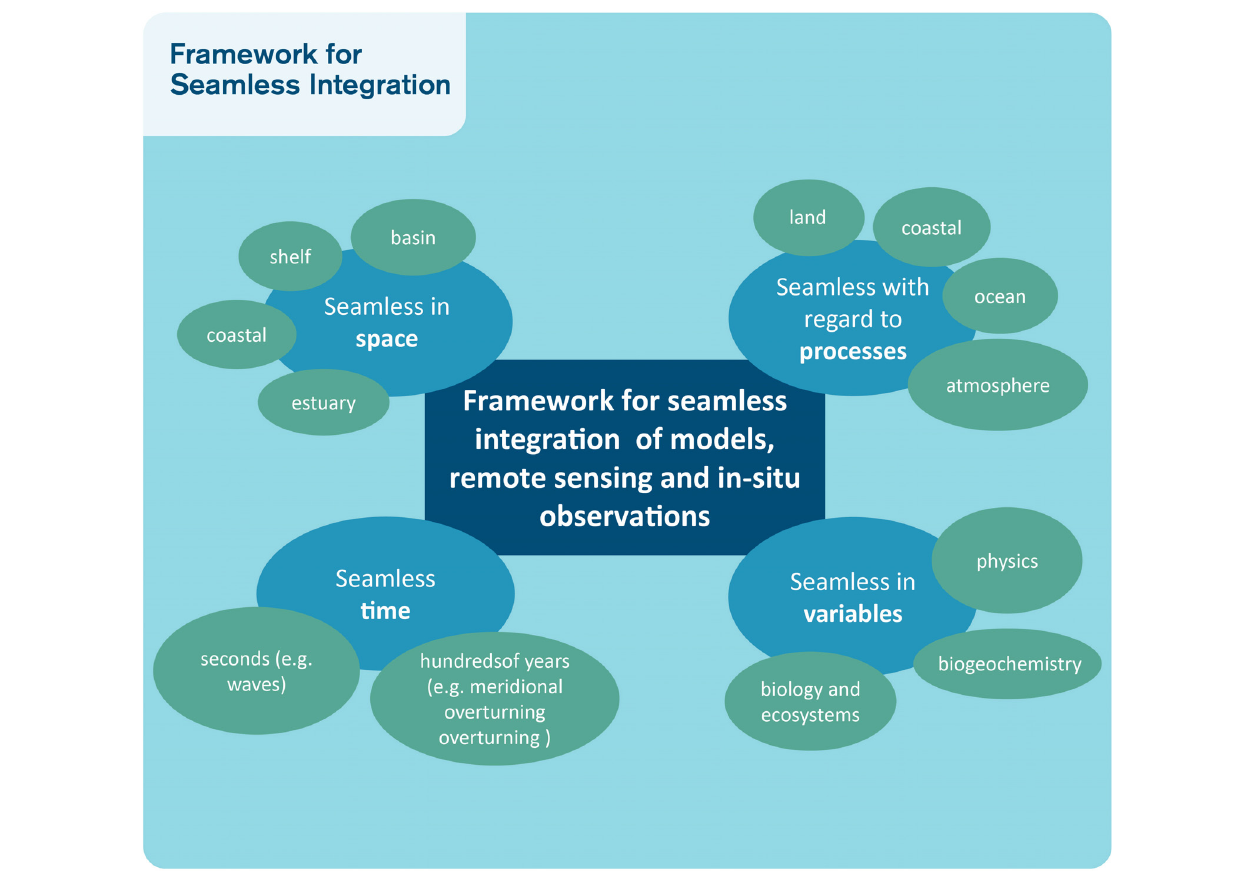
FIGURE 8 | Framework for seamless integration. Content of a framework for the seamless integration of models, remote sensing (satellites) and in situ (in-water)